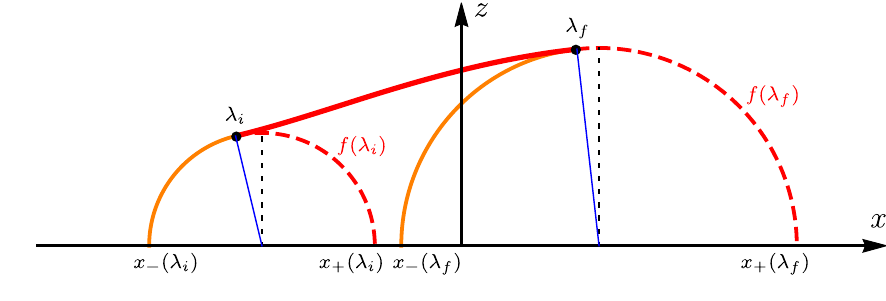
Fig. 5 Geometric interpretation of the boundary term f (λ) in the definition (127) of the renormalized differential entropy E . The value of f at each endpoint is the length of the arcs shown in dotted